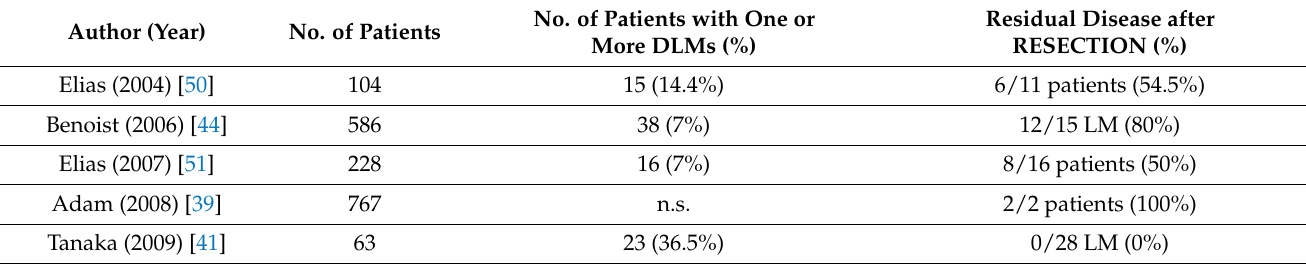
Table 2. The histological results obtained from the study of the resected DLM. DLM: disappearing liver metastasis; LM: liver